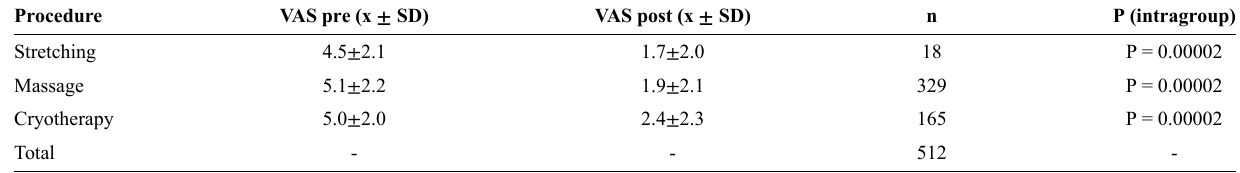
Table 2 - Results of ANOVA between the results of pre and post pain physical therapy procedures for the most frequent reasons for seeking care.